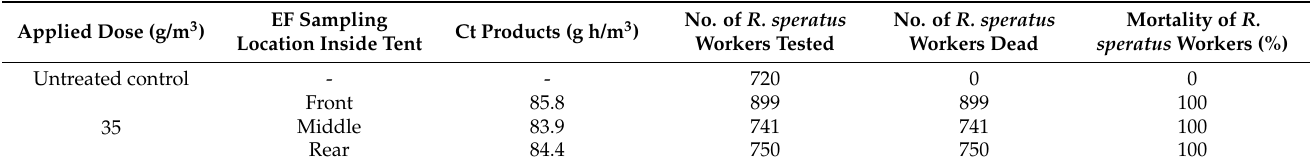
Table 1. Concentration × time (Ct) products (g h/m 3 ) of and the mortality of Reticulitermes speratus workers from 35 g/m 3 EF fumigation at 15 ± 1 ◦ C for 4 h treated on imported potted rubber plants ( Fiscus retusa and F. benghalensis ) in commercial-scale fumigation trials conducted in a 7.2 m 3 PVC-tarpaulin tent.